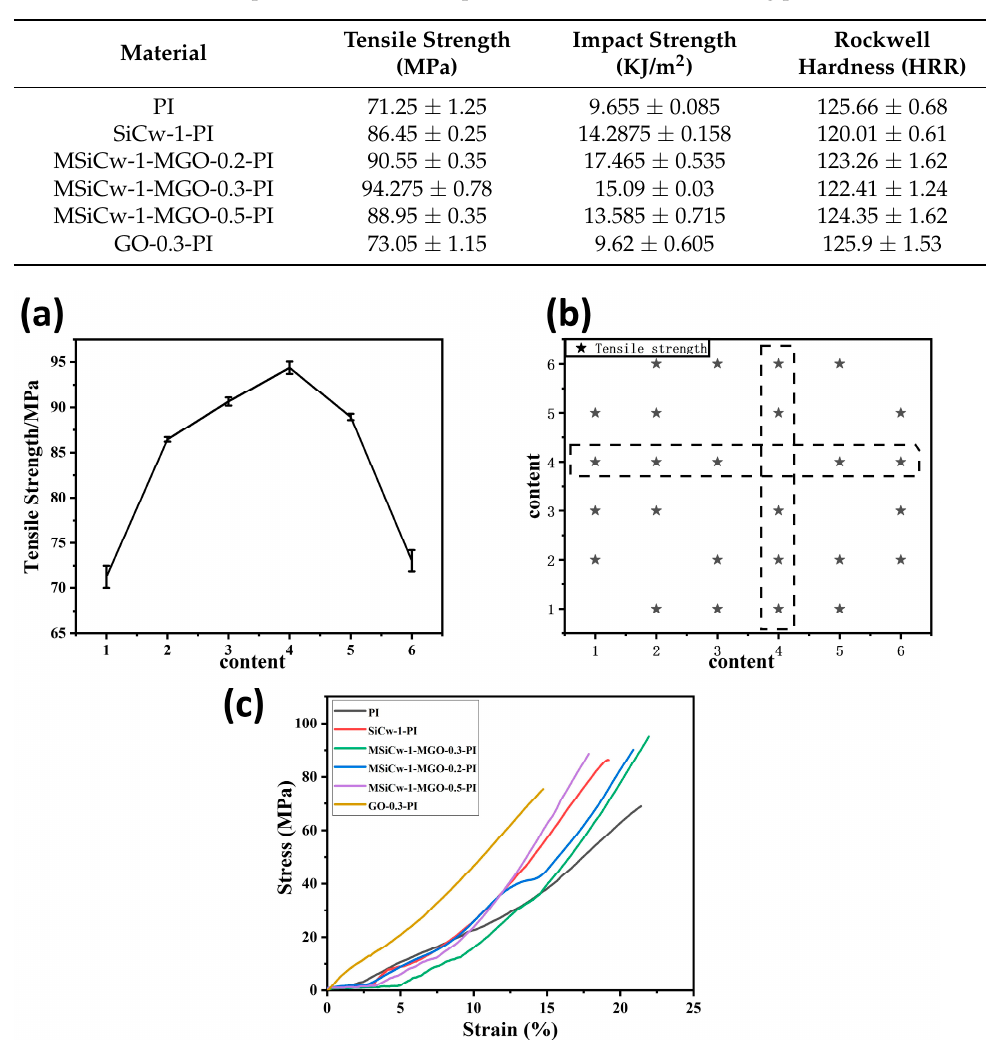
Figure 3. Tensile strength ( a ) and stress–strain ( c ) curves of different types of polyimine composites: Polyimine (1), SiCw-1-PI (2), MSiCw-1-MGO-0.2-PI (3), MSiCw-1-MGO-0.3-PI (4), MSiCw-1-MGO- 0.5-PI (5), GO-0.3-PI (6). The statistical significance ( P < 0.05) for the pairwise comparisons of tensile strength ( b ) (stars) among the composites with different reinforcing phases